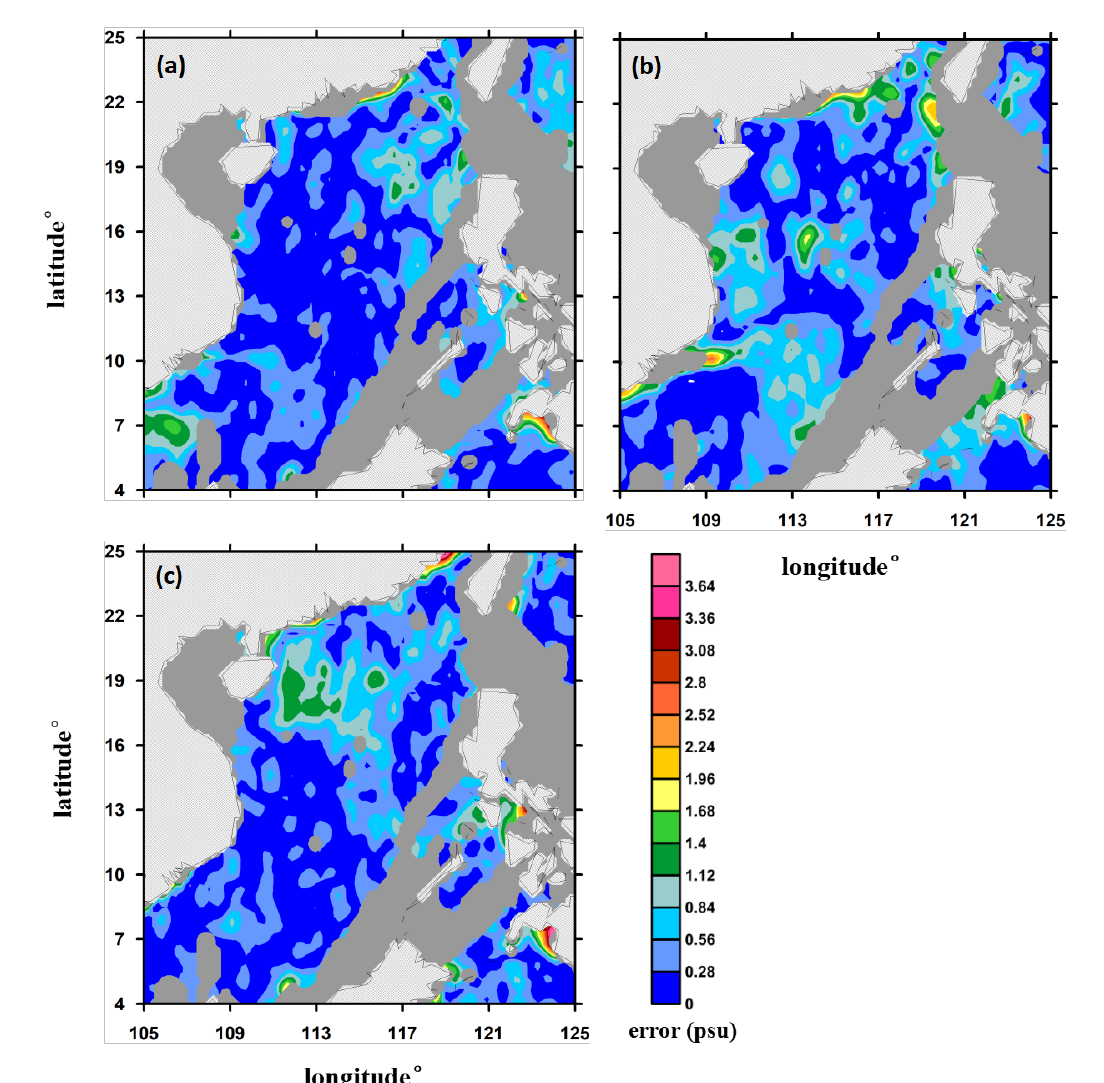
Figure 8. The absolute error of CATDS SMOS level3 product. CMEMS GOER sea surface salinity product is chosen as the reference for comparison. ( a ) is the error between the CATDS SMOS level3 product and the CMEMS referenced SSS from 11 to 19 June 2018, ( b ) is the error from 11 to 19 September 2018, and ( c ) is the error from 12 to 20 December 2018. All images have been truncated to the SCS region. The light gray in the images represents the land area and the dark gray is the area that is blanked out because of large error induced by RFI and other